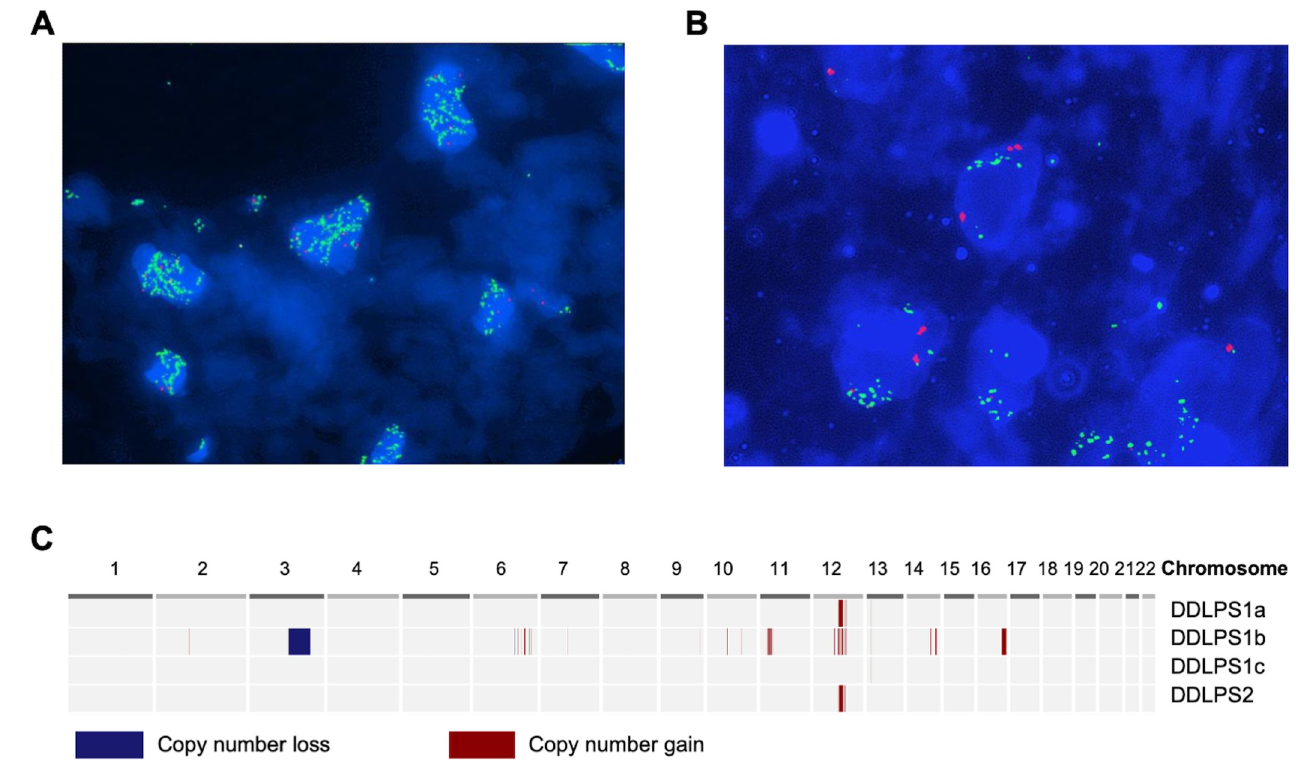
Fig 1. MDM2 amplification in tumor specimens and genome-wide DNA copy number profiles of plasma specimens of two patients with DDLPS. A) and B) Detection of high-level amplification of MDM2 in tumor specimens from patients DDLPS1 and DDLPS2, respectively. Green fluorescent signal–ZyGreen labeled polynucleotides, which target sequences at 12q15 harboring the MDM2 gene region. Red fluorescent signal–ZyOrange labeled polynucleotides, which target sequences at 12p11.1-q11 specific for the alpha satellite centromeric region D12Z3 of chromosome 12. C) Copy number alterations detected in autosomal cell-free DNA of patients DDLPS1 and DDLPS2. The MDM2 gene is in the 12q15 locus.